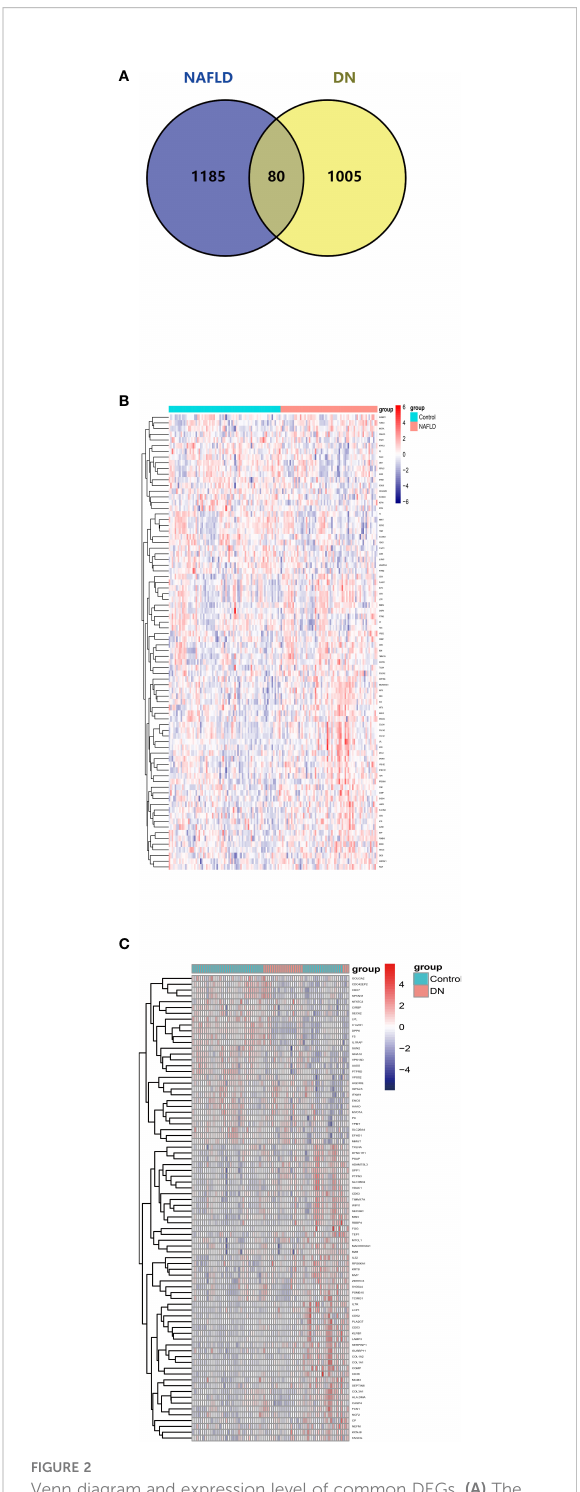
FIGURE 2 Venn diagram and expression level of common DEGs. (A) The intersection of DEGs in the NAFLD merged dataset and DN merged dataset from GEO contains 80 optimal crosstalk genes. The expression level of 80 common DEGs in the NAFLD merged dataset (B) and DN merged dataset (C)